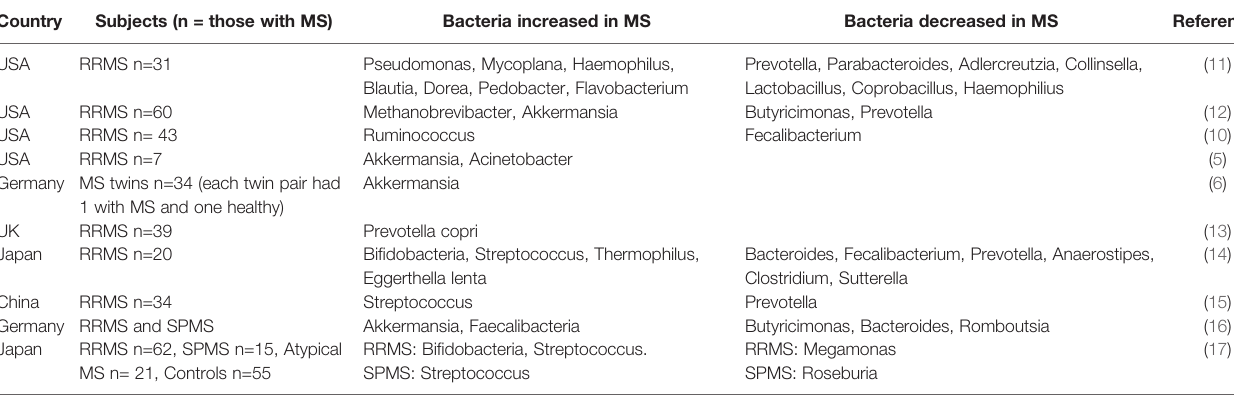
TABLE 1 | Comparison of the nature of dysbiosis reported in different studies in patients with MS. Country Subjects (n = those with MS) Bacteria increased in MS Bacteria decreased in